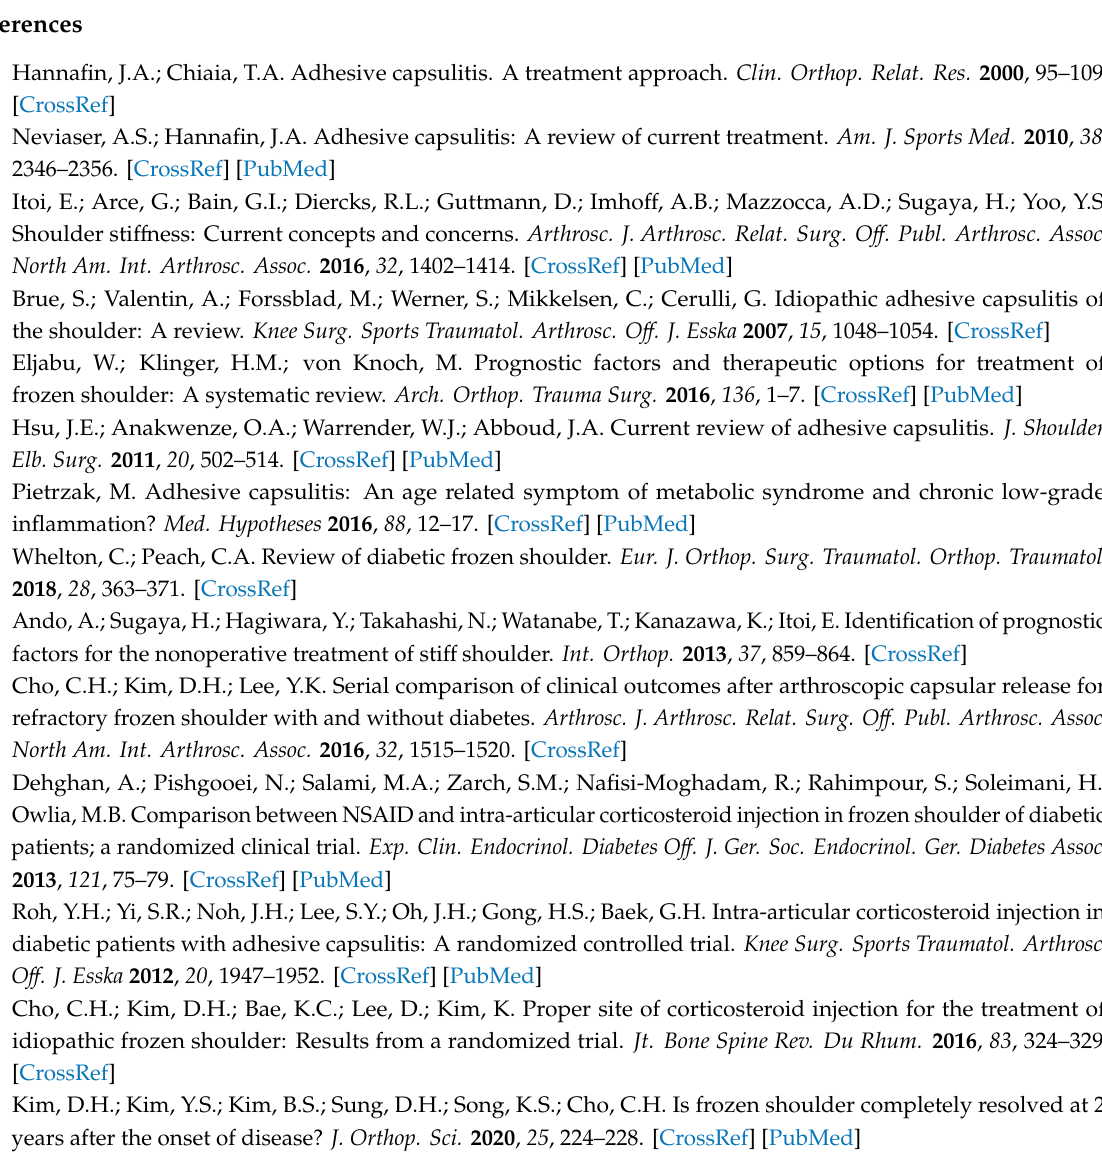
FS group. A single intra-articular steroid injection can be used as a conservative treatment of diabetic FS, but its e ff ect in diabetic FS is less than that in idiopathic